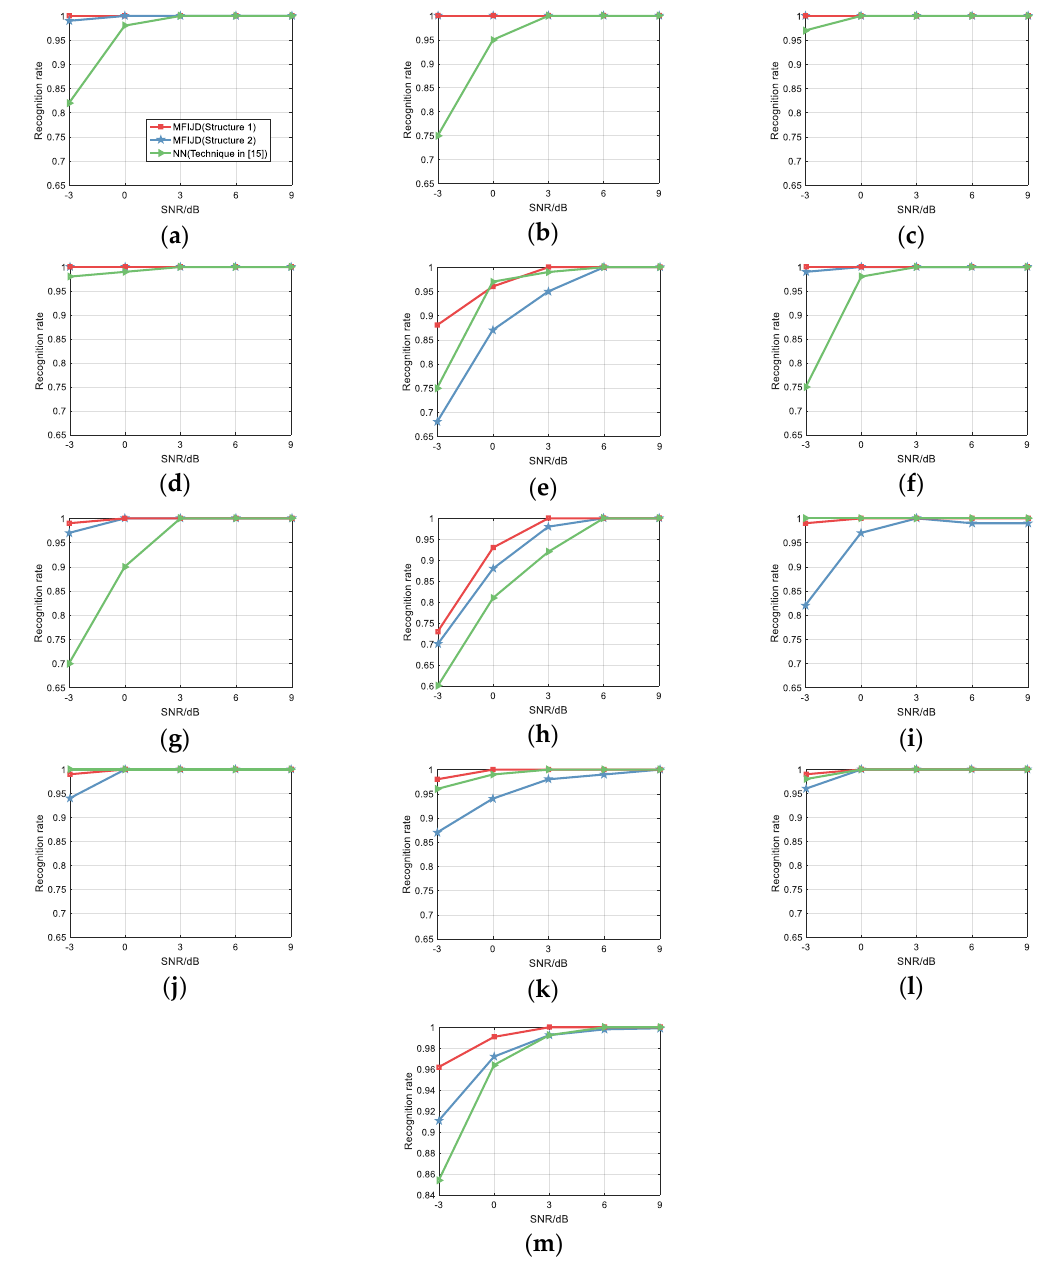
Figure 20. Comparison with the waveform classification in [15]: ( a ) Frank; ( b ) LFM; ( c ) Costas; ( d ) BPSK; ( e ) P1; ( f ) P2; ( g ) P3; ( h ) P4; ( i ) T1; ( j ) T2; ( k ) T3; ( l ) T4; and, ( m ) Overall.